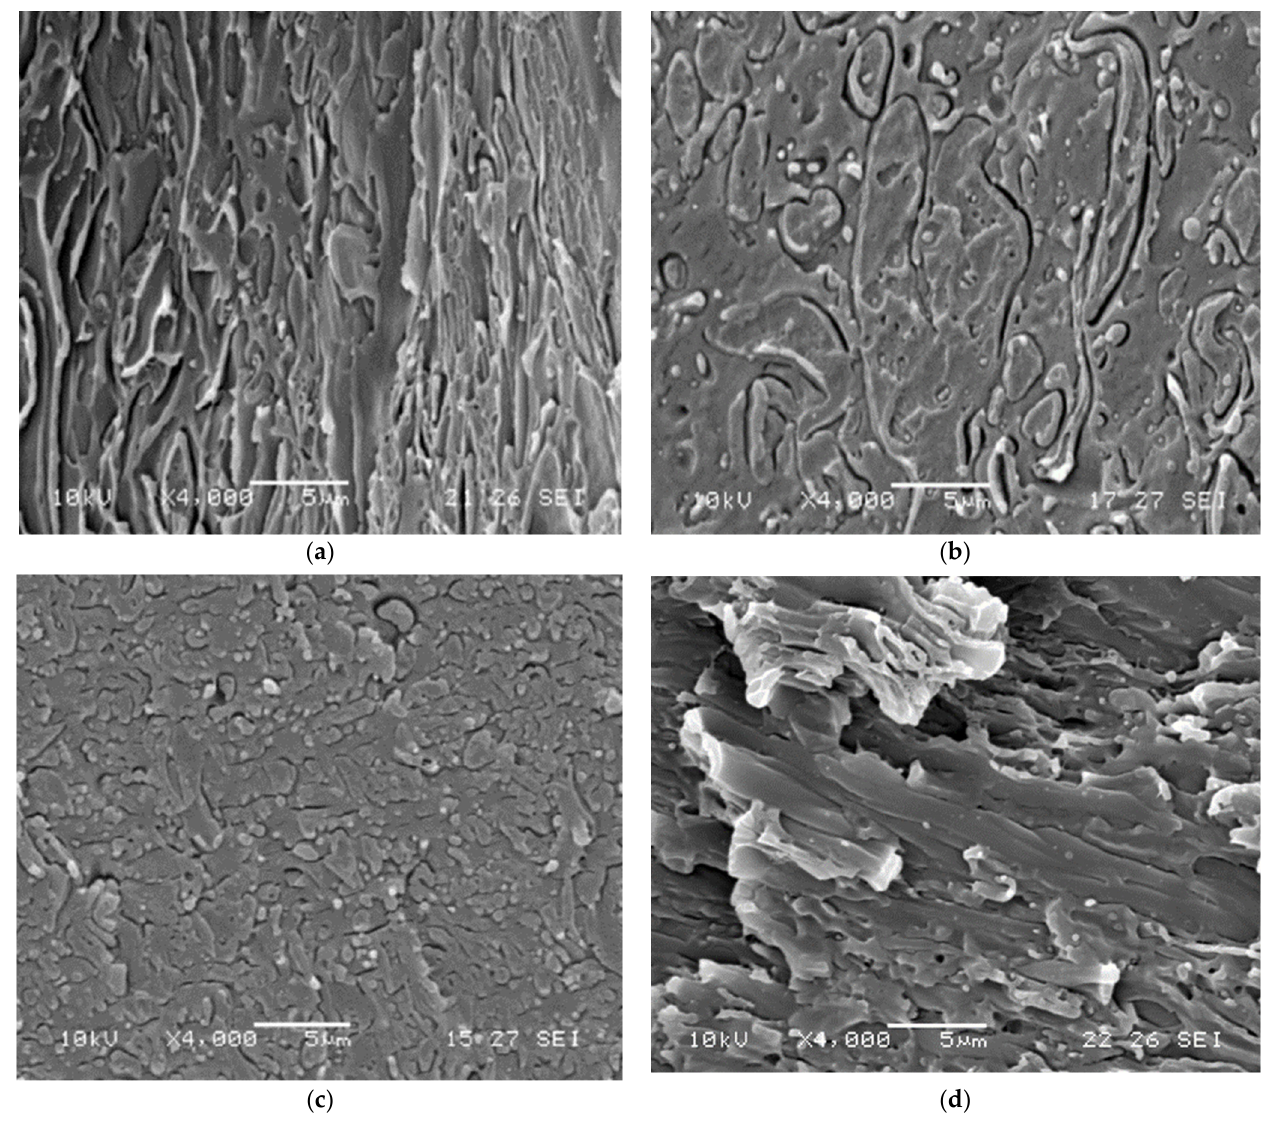
Figure 6. SEM Micrographs of ( a ) R-PLA60/R-PC40, ( b ) R-PLA40/R-PC60, ( c ) R-PLA60/R-PC40 + CATA, ( d ) R-PLA40/R-PC60 + CATA .